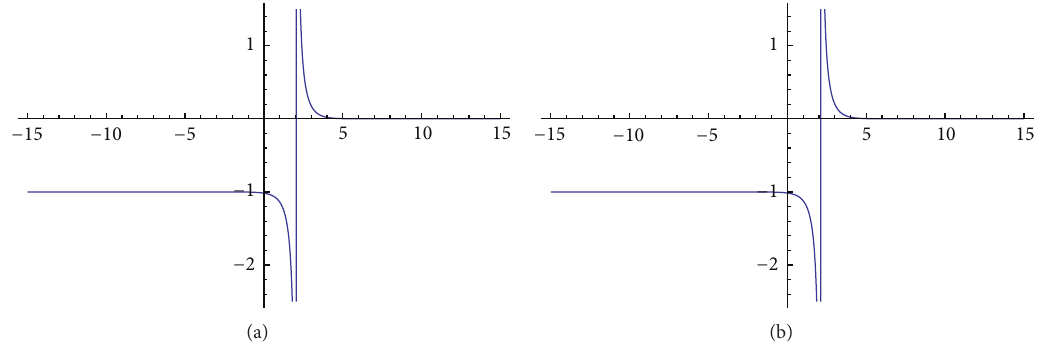
Figure 6: Two-dimensional graph of the solution (29) corresponding to the values 𝛼 = 0.05 , 𝛼 = 0.85 , respectively, when 𝑘 = 1 , 𝑝 = 1 , 𝛽 = 4 , 𝑡 = 1 , and −15 < 𝑥 < 15